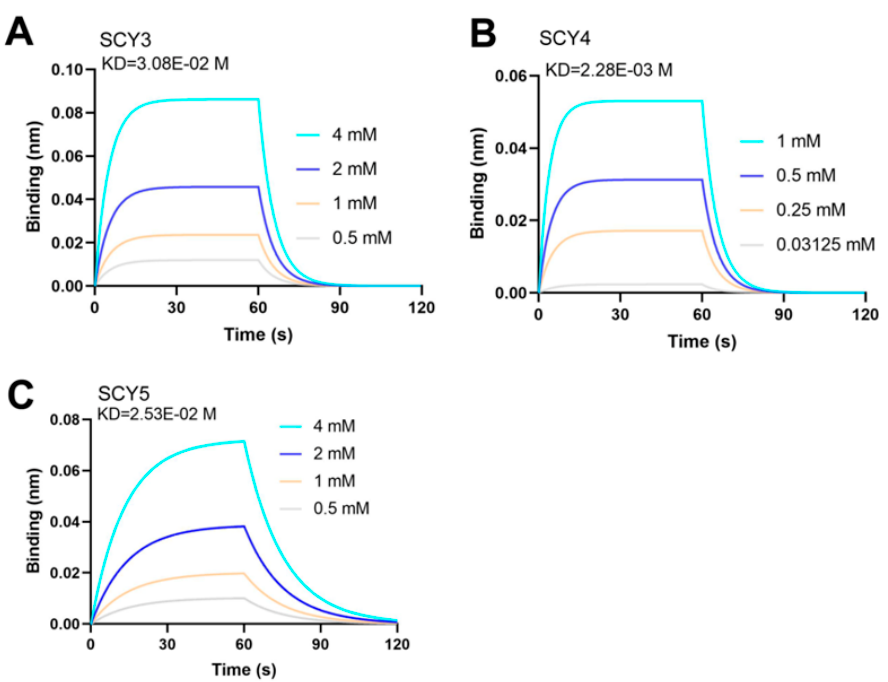
Figure 8. Affinity measurements between progesterone and rSCY3 ( A ); rSCY4 ( B ); and rSCY5 ( C ) by BLI.